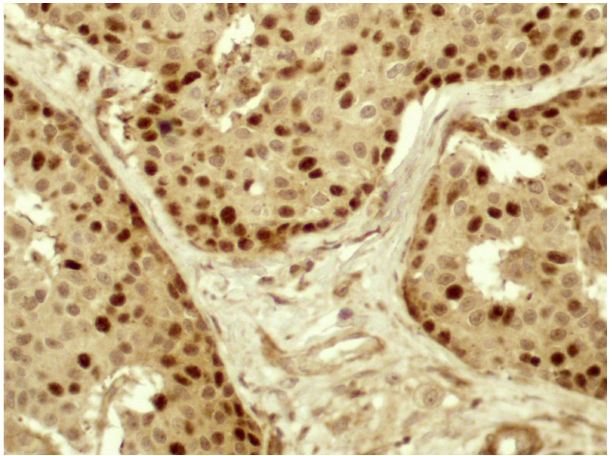
Figure 2. In most cases, Twist reactivity was located mainly at the periphery of the neoplastic nests, at strict contact with the stroma (40 ×